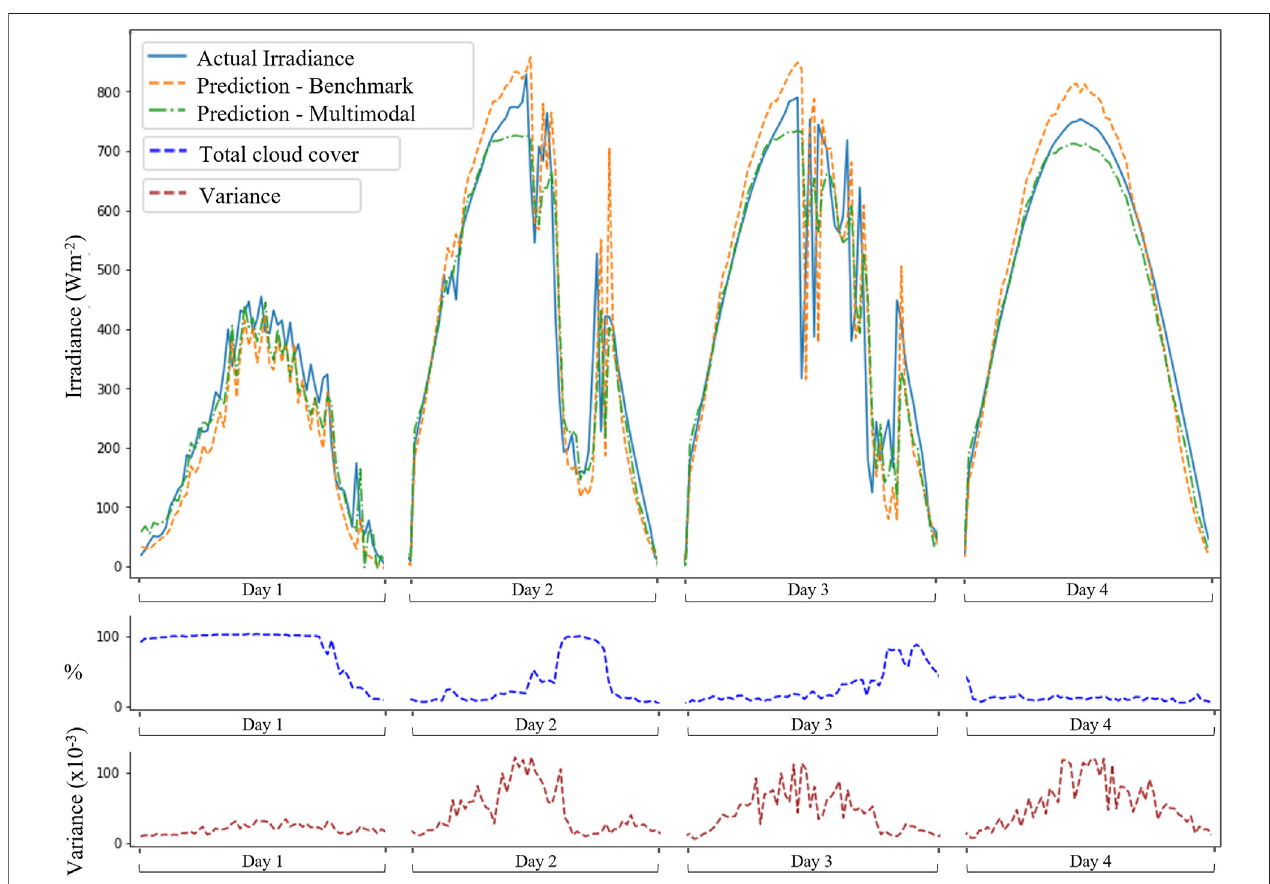
FIGURE 10 | Actual irradiance, irradiance nowcasting, cloud cover and uncertainty measurement across 4 days during winter.